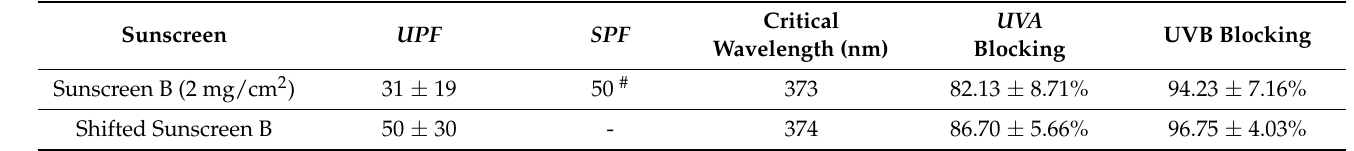
Figure 6. Illustration of the limitations of current measures of sun protection. The solid curve shows the measured transmittance of Sunscreen B applied at 2 mg/cm 2 , which has a SPF rating of 50 but had a measured UPF of only 31. The dashed curve was generated using a shifting function to simulate a transmittance curve with an average UPF of 50. For both the measured and simulated curve, the rapid increase in transmittance in the UVA region represents reduced protection from UVA radiation. Table 4. Data from Shifting Sunscreen B Transmittance Curve to Simulate UPF = 50.